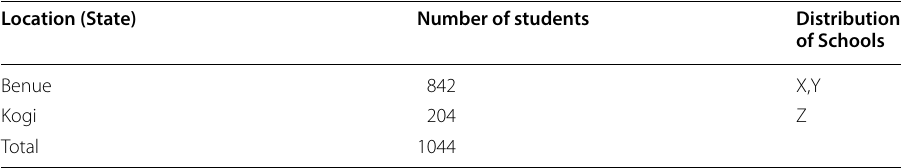
Table 3 Statistical Features of the Dataset Location